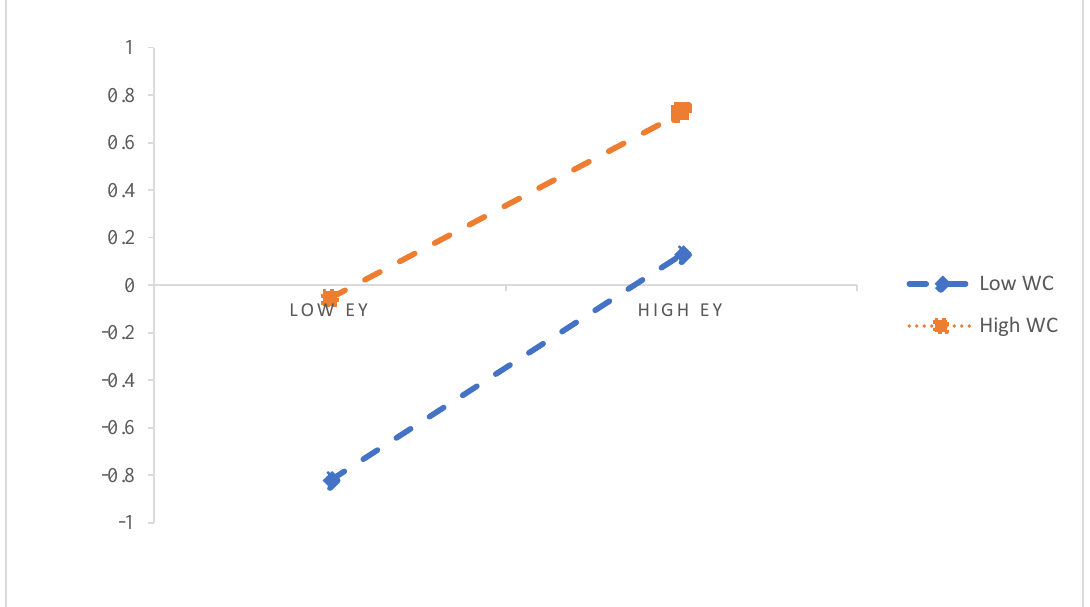
Figure 3. The moderating role of WC in the relationship between Ey and IWB.